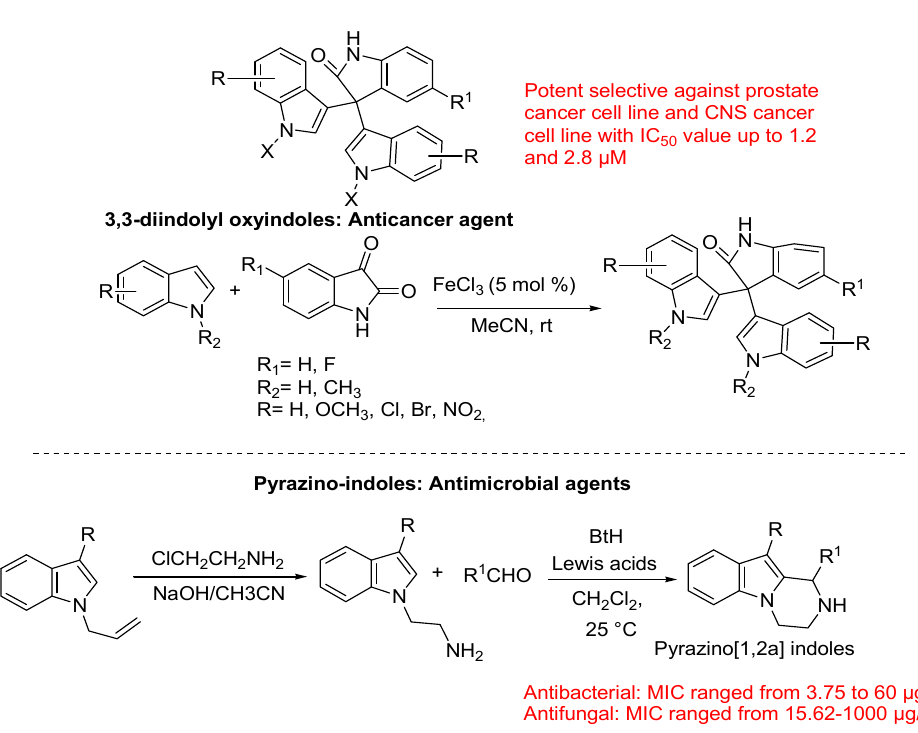
Figure 35. 3,3-Diindolyl oxyindoles and pyrazino[1,2 α